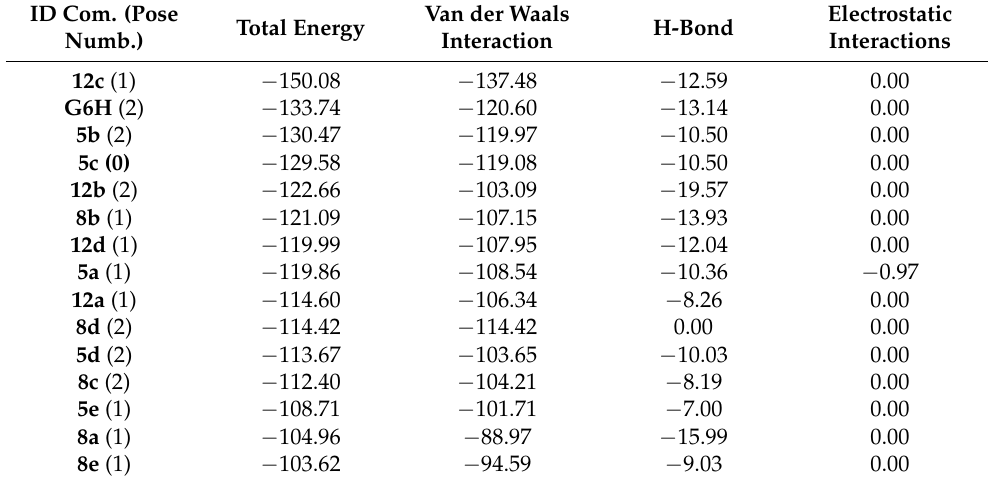
Table 4. Ranking of the screened compounds with the energies (kcal mol − 1 ) of pharmacological interactions with tyrosine-protein kinase c-Src (PDB: 3G6H) (kcal mol − 1 ). Electrostatic Van der Waals ID Com. (Pose H-Bond Total Energy Interaction Numb.)